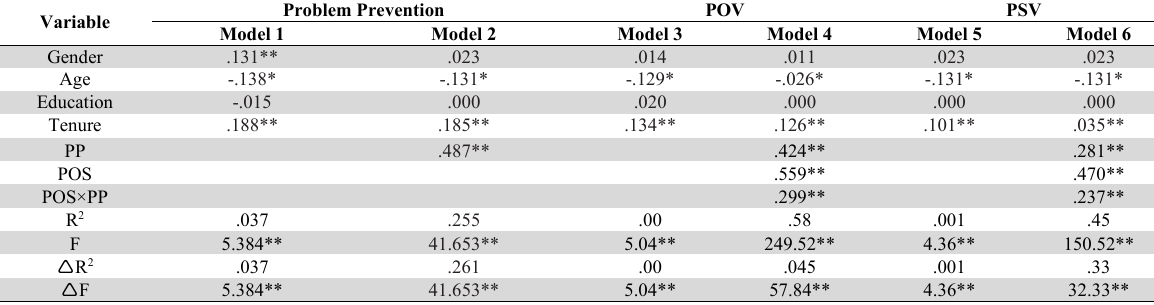
Moderation effects Variable